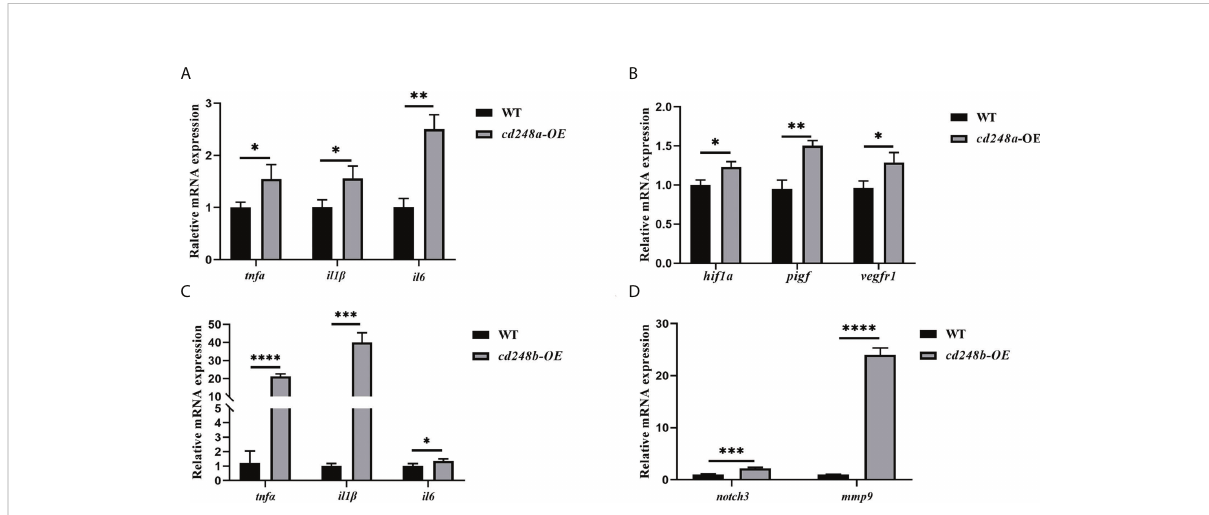
FIGURE 9 Effect of overexpression of zebra fi sh cd248a and cd248b on pro-in fl ammatory cytokines expression in vivo . Diluted mRNAs were injected into one-cell stage embryos of zebra fi sh. At 48h after injection, the total RNA of the embryos was extracted and cDNA was synthesized. (A, C) Quantitative analysis of the expression of tnf a , il1 b and il6 after cd248a and cd248b overexpression in embryos; (B) Quantitative analysis of the expression of hif1a , pigf and vegfr1 after cd248a overexpression in embryos; (D) Quantitative analysis of the expression of notch3 and mmp9 after cd248b overexpression in embryos. cd248a -OE, cd248a overexpression; cd248b -OE, cd248b overexpression. Data were shown as mean ± SD. * P < 0.05; ** P < 0.01; *** P < 0.001; **** P <